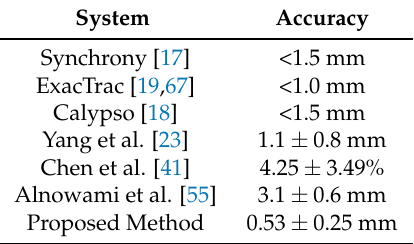
Table 3. Accuracy comparison of the proposed method with related respiratory motion tracking